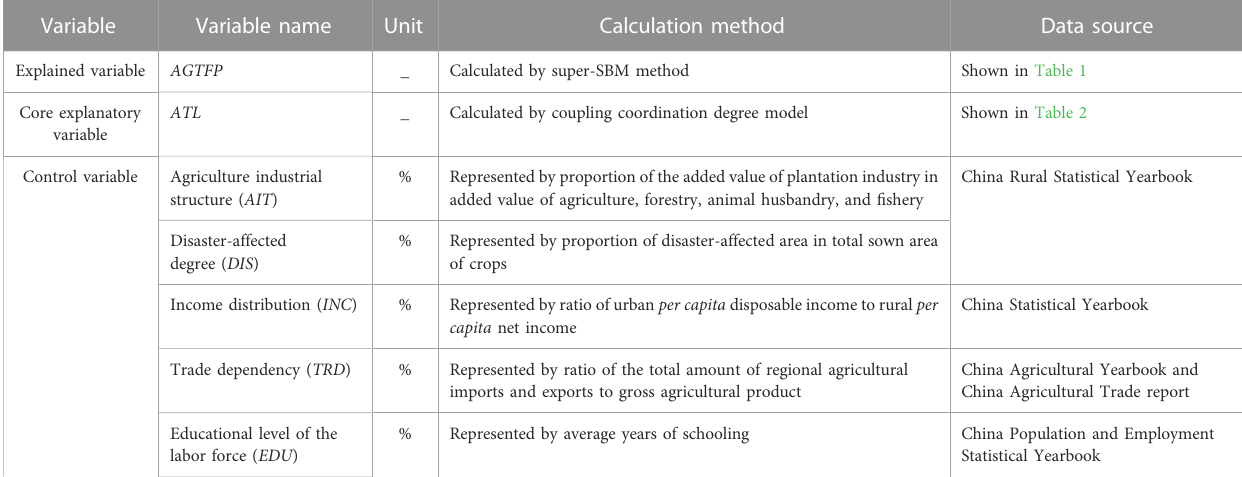
TABLE 3 Relevant variables and descriptions.